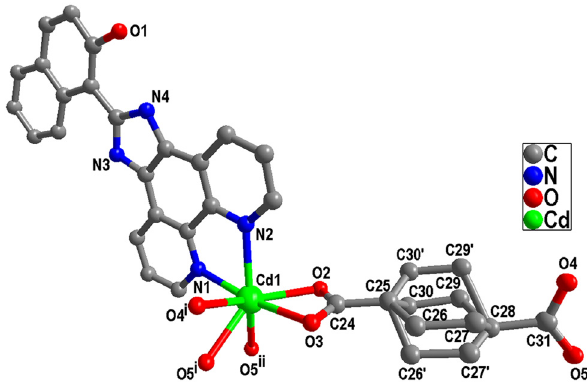
Figure 4: View of the π – π interactions between two L ligands of neighboring layers.